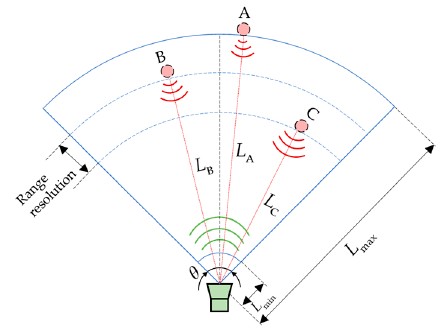
Figure 8. Schematic diagram of measuring range.